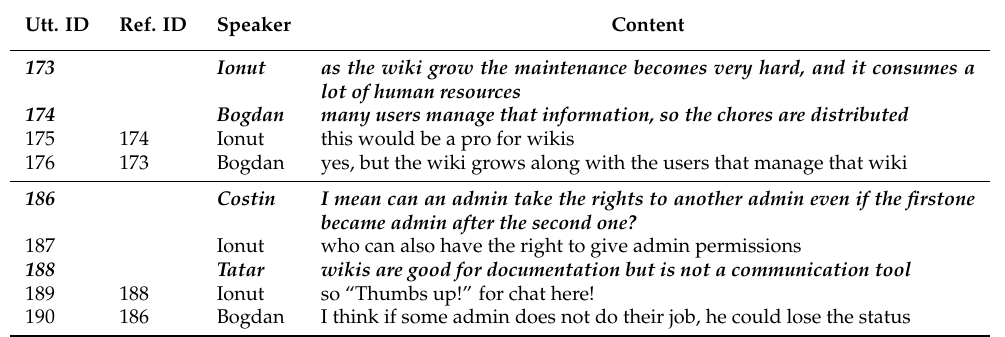
Table 8. Example of correct semantic link prediction ( explicit link / predicted link ).